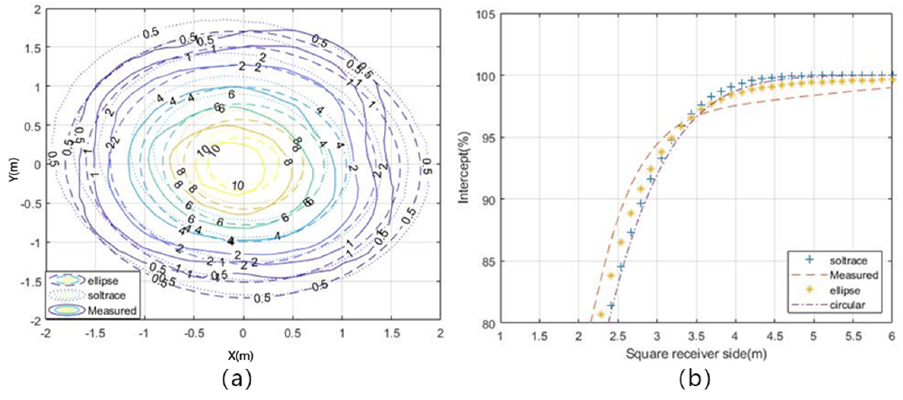
Figure 8. ( a ) Contours of the measured and computed flux distribution (kW/m 2 ): Heliostat #2, ( b ) measured and computed intercepts vs. the side length of a square receiver: Heliostat #2 .